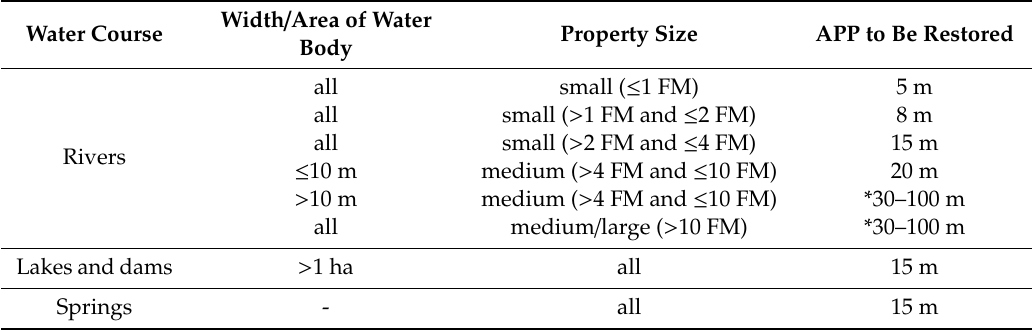
Table 3. Legal requirements for restoring permanent preservation areas (APPs) under the Brazilian environmental law (Law no. 12651, 25 March 2012) for rural properties. These requirements are applied to APPs deforested before 22 July 2008. FM is the number of fiscal modules.